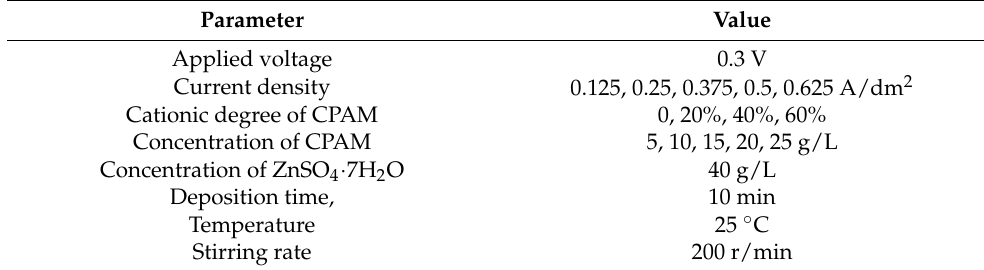
Table 1. Experiment